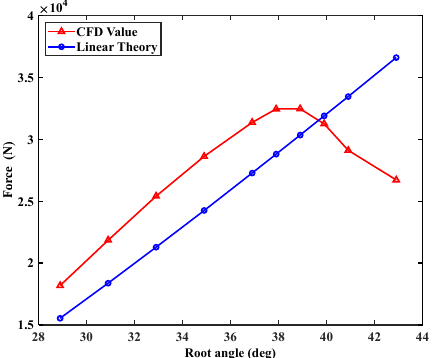
Figure 18. VDDF lift force calculation in hovering.